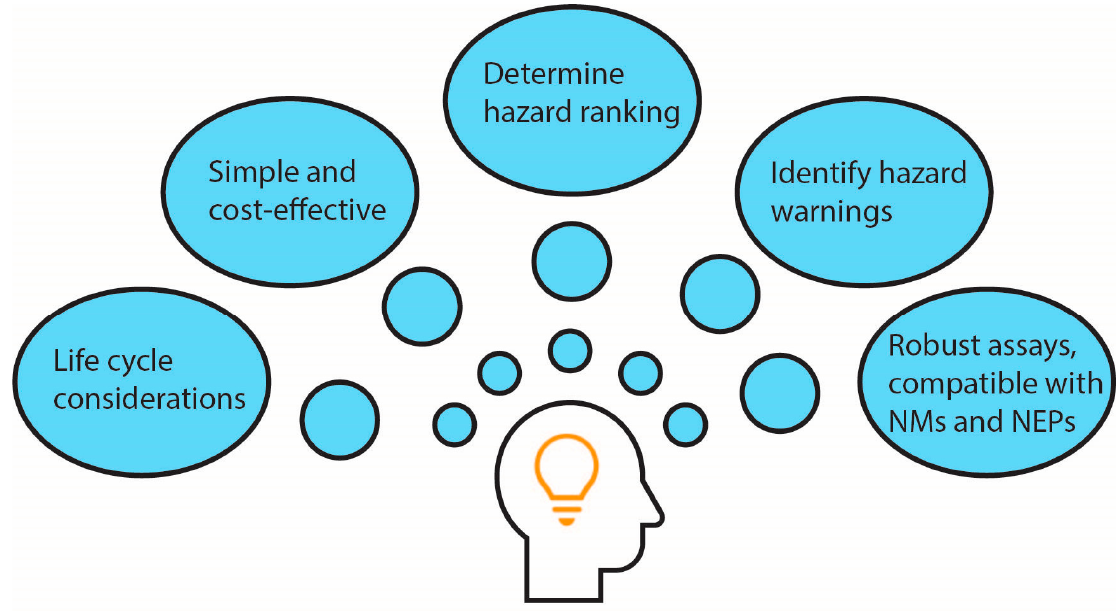
Figure 1. Considerations for assay selection for SbD hazard testing.